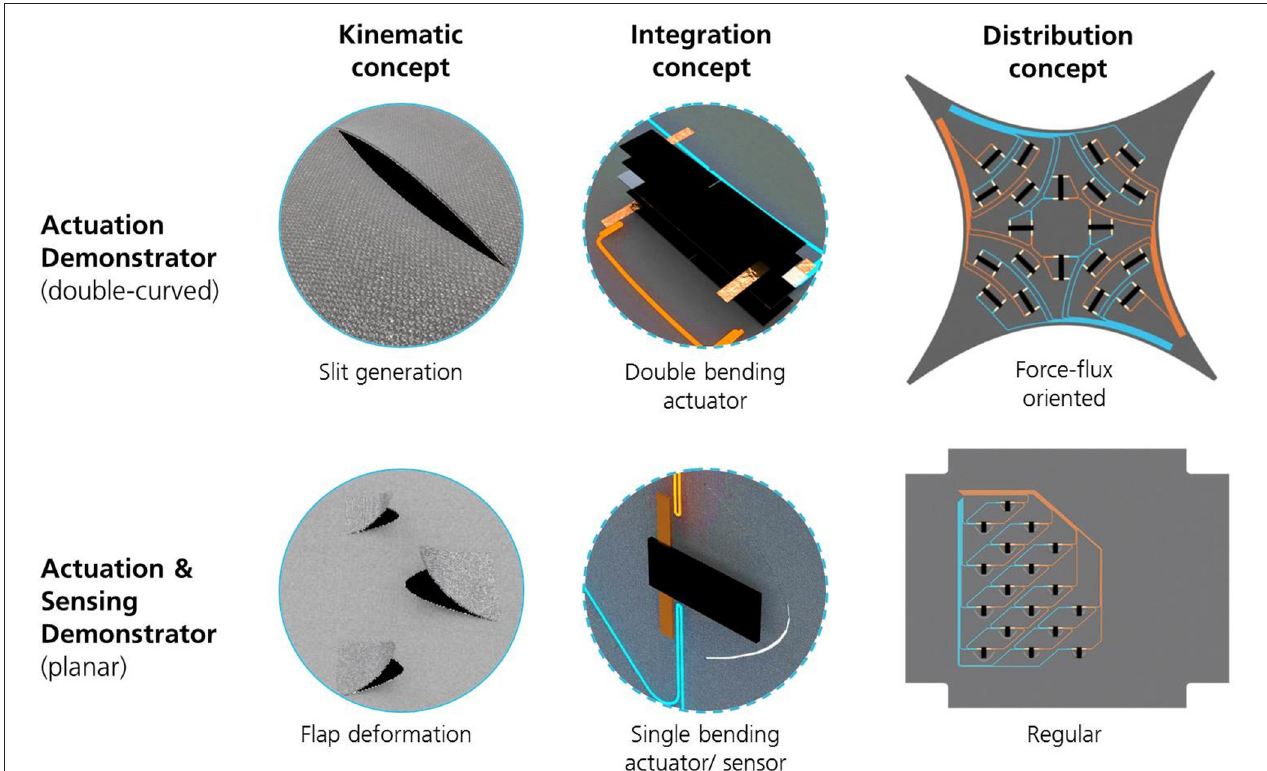
FIGURE 8 | Concepts for IEAP integration and distribution for an actuation-only demonstrator and an actuation & sensing demonstrator. The orange and blue lines indicate the placement of the electric power distribution.